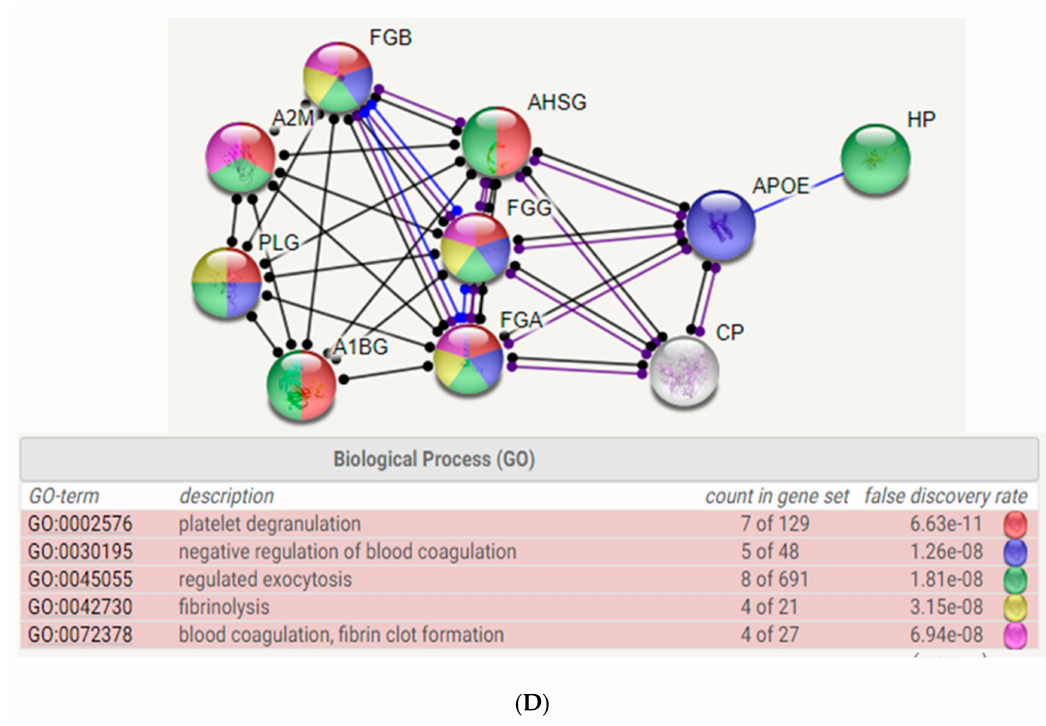
Figure 2. ( A ) Silver-stained 2-DE patterns of plasma and plasma depleted of albumin. N: health donor; WD: Wilson’s disease patients. Most albumins in plasma samples from health donor and WD were removed by using a Millipore Montage Albumin Deplete kit. The protein spots with significantly increasing intensity were labeled as Arabic numerals. Of these thirty one spots, 4 spots which appeared in normal samples were expressed in high level. Conversely, the other 14 spots were found in more abundant quantity for WD samples. ( B ) Peptide mass fingerprints of human fibrinogen β chain by. After 2-DE separation, spots was digested with trypsin and applied to MALDI-TOF mass spectrum which marked 9 in Table 1. By mean of Mascort software, 13 peptides with m / z values could be matched to accession number from Swiss-Prot database. Matched peptides showed with underline within the internal amino acid sequence of fibrinogen β chain. ( C ) Biological network analyses of di ff erentially expressed proteins using MetaCore ™ mapping tools. Nodes represent proteins and lines between the nodes indicate direct protein–protein interactions. The various proteins on this map are indicated by di ff erent symbols representing the functional class of the proteins. ( D ) Top-ranked pathways from the GeneGo MetaCore pathway analysis. Pathways were ranked according to p